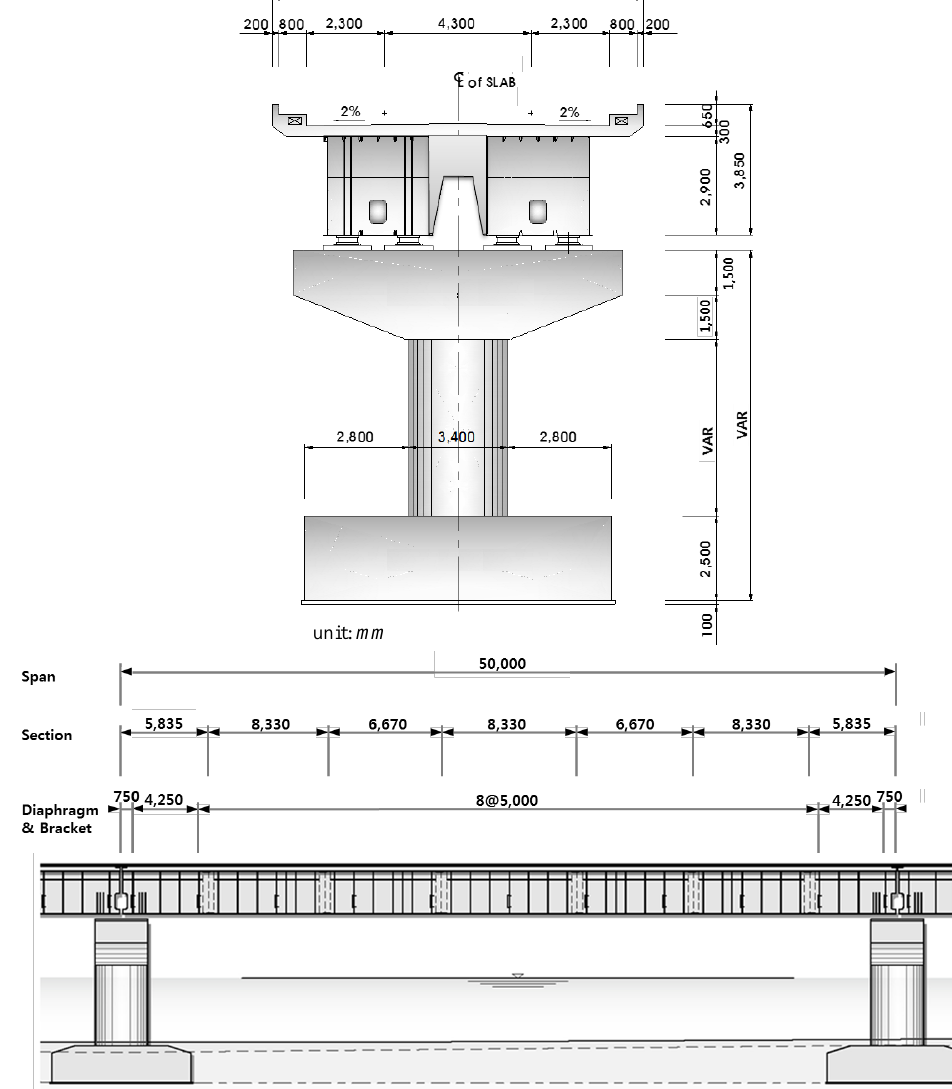
Figure 11. Drawings of a sample steel box girder bridge.